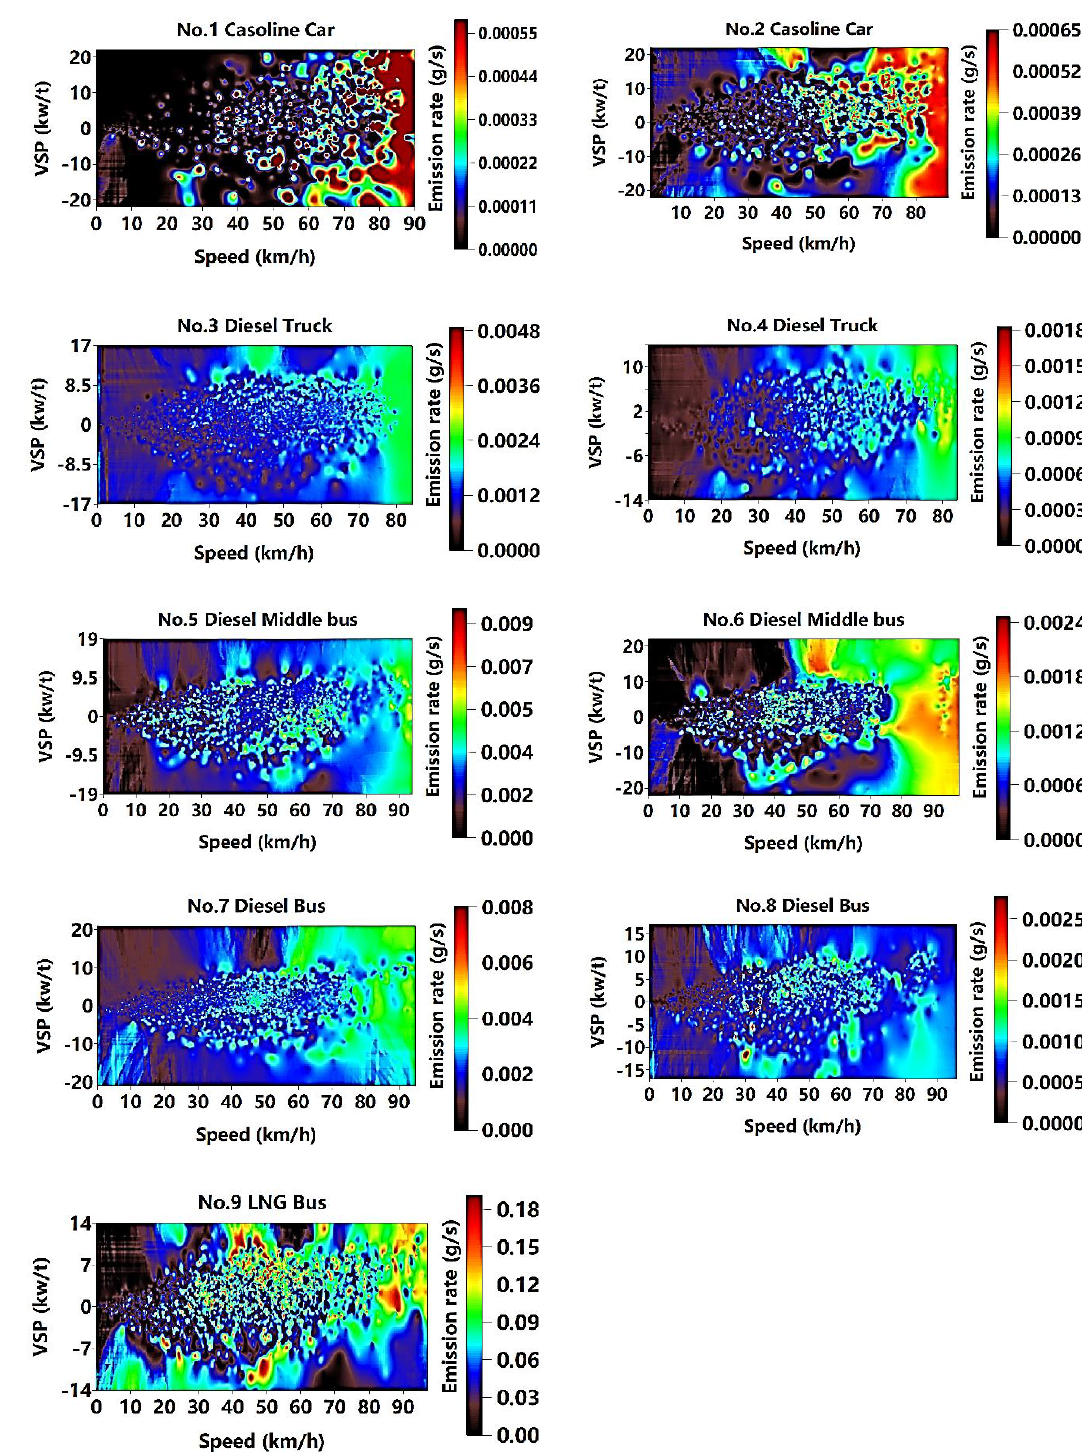
Figure 3. The image maps of the relationship between speed-VSP and HC emission rates. HC emission rates are represented by the colors. The black, brown, blue, cyan, green, yellow, orange, red, and ruby red areas indicate that the emission rates are approximately 0, 0.5, 1, 1.5, 2, 2.5, 3, 3.5, and over 4 times the average emission rate, respectively. Speed is at the X-axis, and VSP is at the Y-axis.